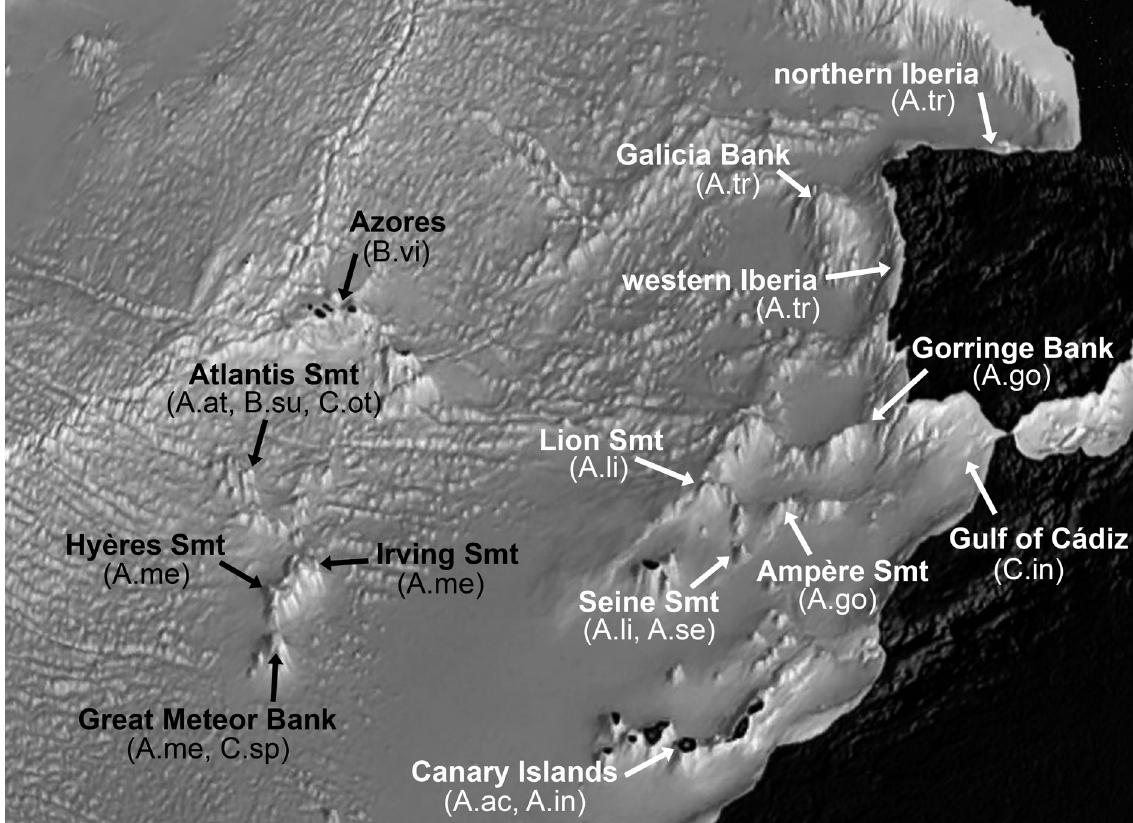
Fig. 16. Geographic distribution of the species of Atlantisina gen. nov., Bathycyclopora gen. nov. and Calvetopora gen. nov.; names in white represent sites on or close to the continental shelf, whereas names in black indicate offshore seamount and island sites. Abbreviations: A.ac = Atlantisina acantha gen. et sp. nov.; A.at = Atlantisina atlantis gen. et sp. nov.; A.go = Atlantisina gorringensis gen. et sp. nov.; A.in = Atlantisina inarmata gen. et sp. nov.; A.li = Atlantisina lionensis gen. et sp. nov.; A.me = Atlantisina meteor gen. et sp. nov.; A.se = Atlantisina seinensis gen. et sp. nov.; A.tr = Atlantisina tricornis gen. et sp. nov.; B.su = Bathycyclopora suroiti gen. et sp. nov.; B.vi = Bathycyclopora vibraculata gen. et comb. nov.; C.in = Calvetopora inflata gen. et comb. nov.; C.ot = Calvetopora otapostasis gen. et sp. nov.; C.sp. = Calvetopora